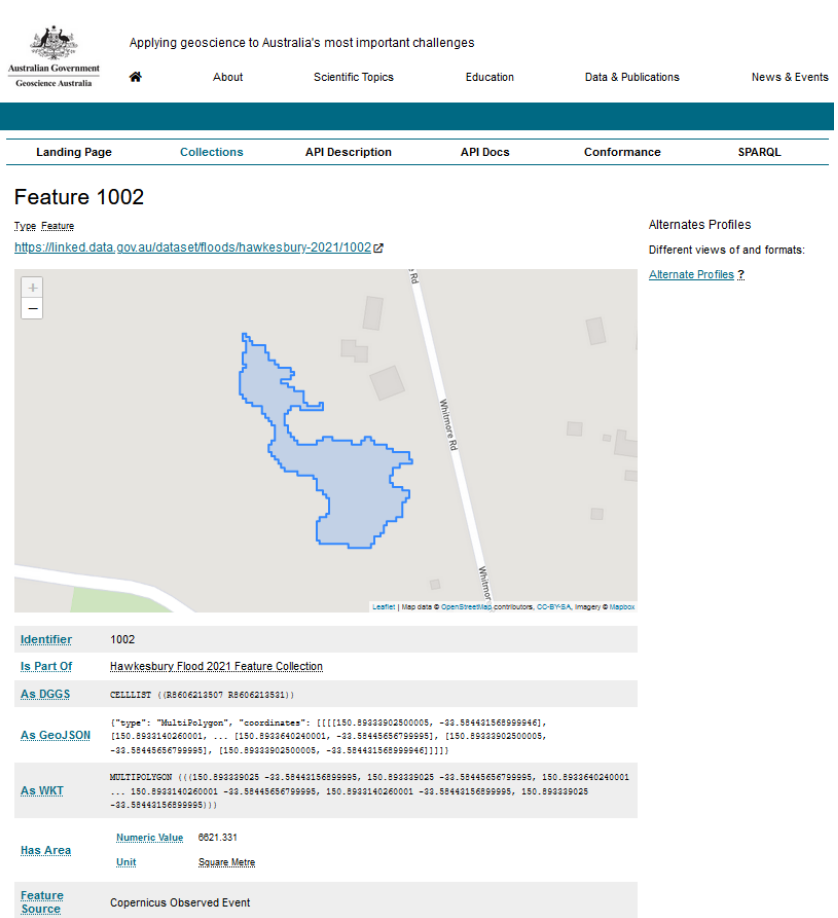
Figure 11. Screenshot of a Linked Data API run by Geoscience Australia that delivers flooded area data online in HTML and RDF forms from a GeoSPARQL 1.1 backend. The API is also an OGC API Features-compatible API since the RDF is converted to (Geo)JSON as